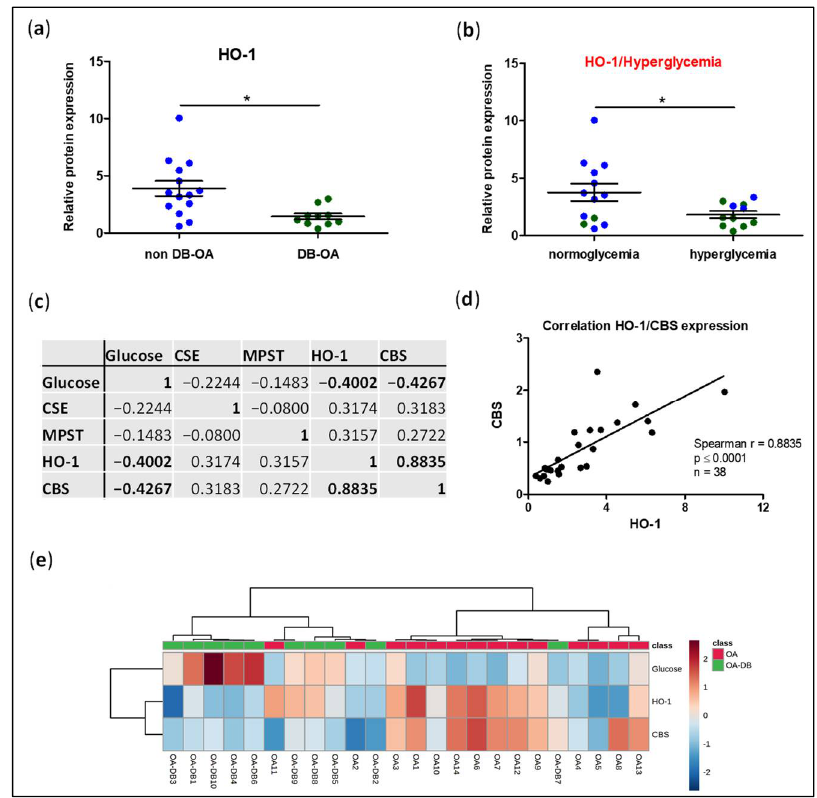
Figure 3. HO-1 expression in cartilage from osteoarthritic patients with or without diabetes and its association with H 2 S synthesising enzymes. ( a ) The protein expression HO-1 was evaluated by western blot in freshly isolated chondrocytes from OA patients without DB (non DB-OA, blue dots; n = 14) or with DB (DB-OA, green dots; n = 10). Additionally, samples were grouped into patients with normoglycaemia or hyperglycaemia ( b ) and levels of HO-1 were analysed in these different subsets of individuals. ( c ) Association between glucose levels, HO-1 and H 2 S synthesising enzymes ( p ≤ 0.05 shown in bold). ( d ) Graph representing Spearman correlation between HO-1 and CBS. Additionally, linear regression is shown. ( e ) Hierarchical clustering heatmap analysis was carried out to identify different OA phenotypes based on a specific profile of variables. Values are mean ± SEM. * p ≤ 0.05 analysed by the Mann–Whitney test. CBS, cystathionine β -synthase;